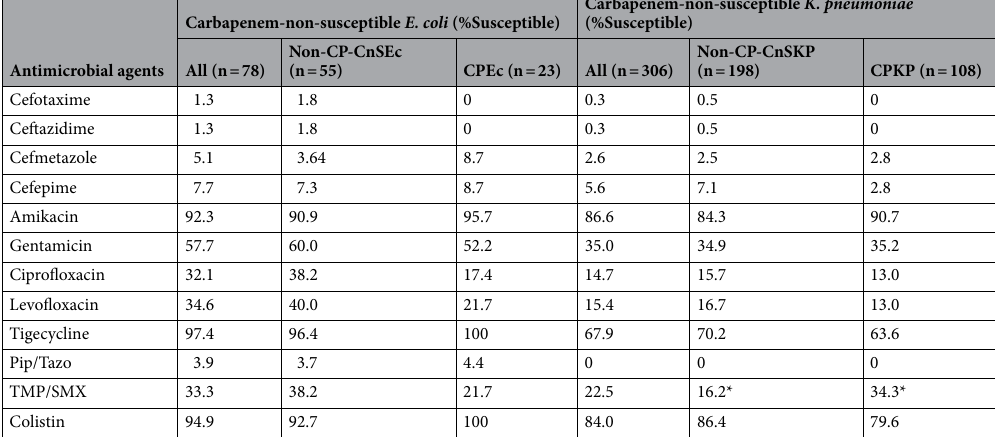
Table 2. Susceptibility patterns of carbapenem-non-susceptible E. coli and K. pneumoniae isolates to different antimicrobial agents. *CPKP vs. Non-CP-CnSKP, p < 0.01. CPEc, carbapenemase-producing E. coli ; CPKP, carbapenemase-producing K. pneumoniae ; MICs, minimal inhibitory concentrations; Non-CP-CnSEc, non-carbapenemase-producing carbapenem-non-susceptible E. coli; Non-CP-CnSKP, non-carbapenemase- producing carbapenem-non-susceptible K. pneumoniae; Pip/Tazo, piperacillin/tazobactam; TMP/SMX, trimethoprim/sulfamethoxazole.